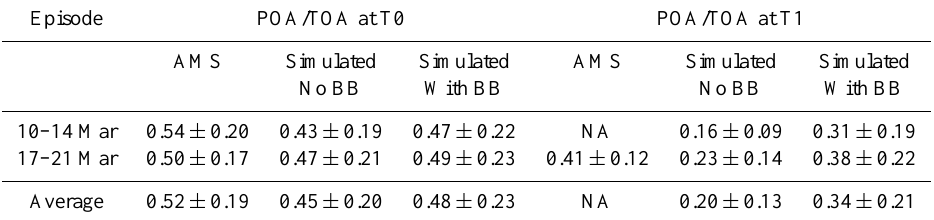
Table 4. Observed and simulated concentration ratios of POA/TOA with and without BB emissions at T0 and T1 during the two fire periods.